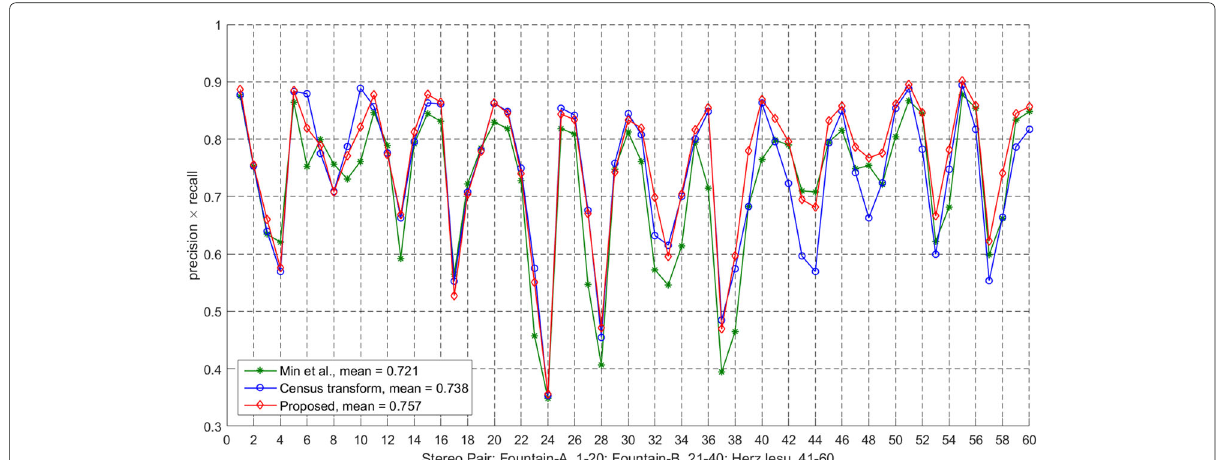
Fig. 8 Performance comparison of three methods on the Fountain and HerzJesu